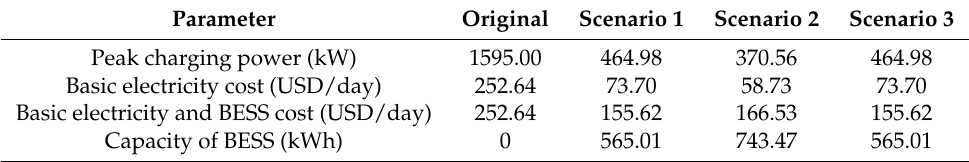
Table 5. Basic electricity and BESS cost optimization of different BESS configuration scenarios.